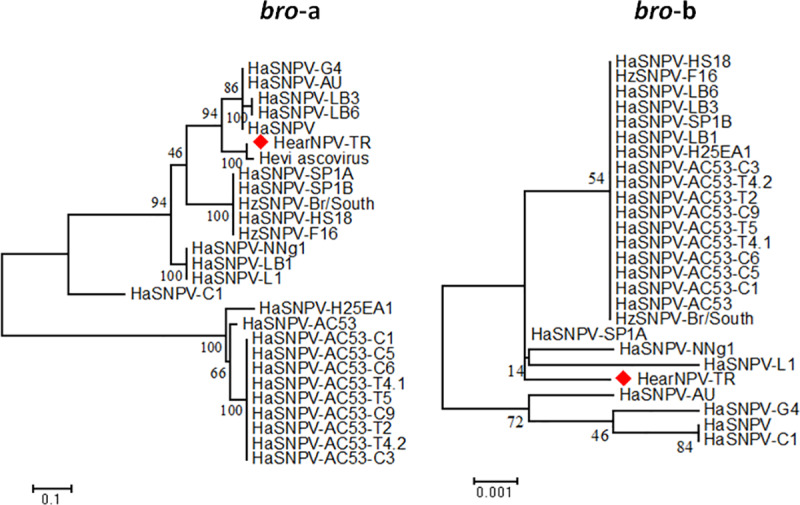
Phylogenetic analysis of bros genes.